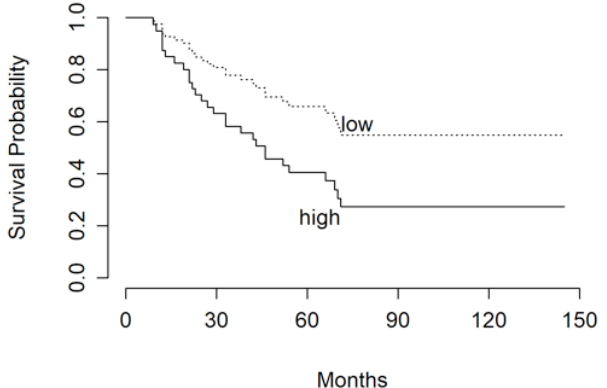
Figure 3. RFS of patients stratified in “low” and “high” risk groups according to the time needed to reach target mitotane concentrations of ≤17 and >17 months, respectively.